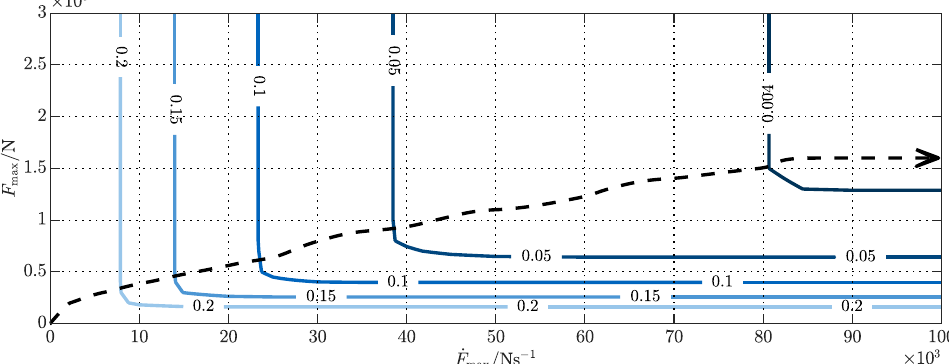
Figure 13. RMS body acceleration contour plot for the 45kmh − 1 AB profile